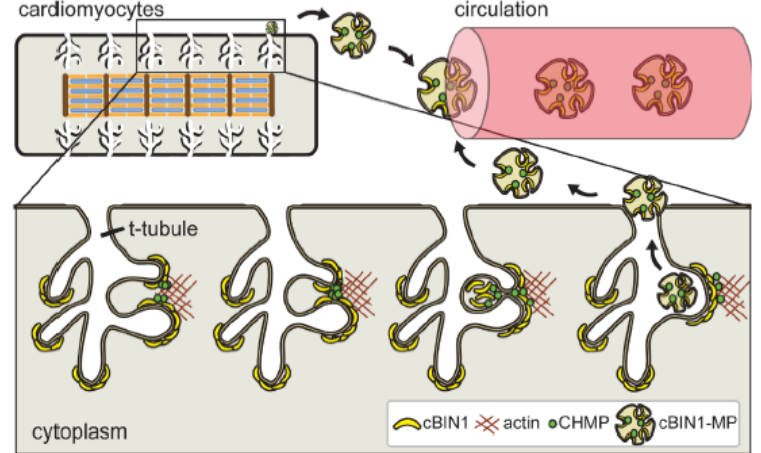
Figure 2. Cardiomyocyte cBIN1-microdomains turn over through CHMP4B-dependent microvesicle formation and release from t-tubule membrane, resulting in cardiac origin cBIN1-vesicles flowing in the peripheral circulation as a marker of cardiomyocyte